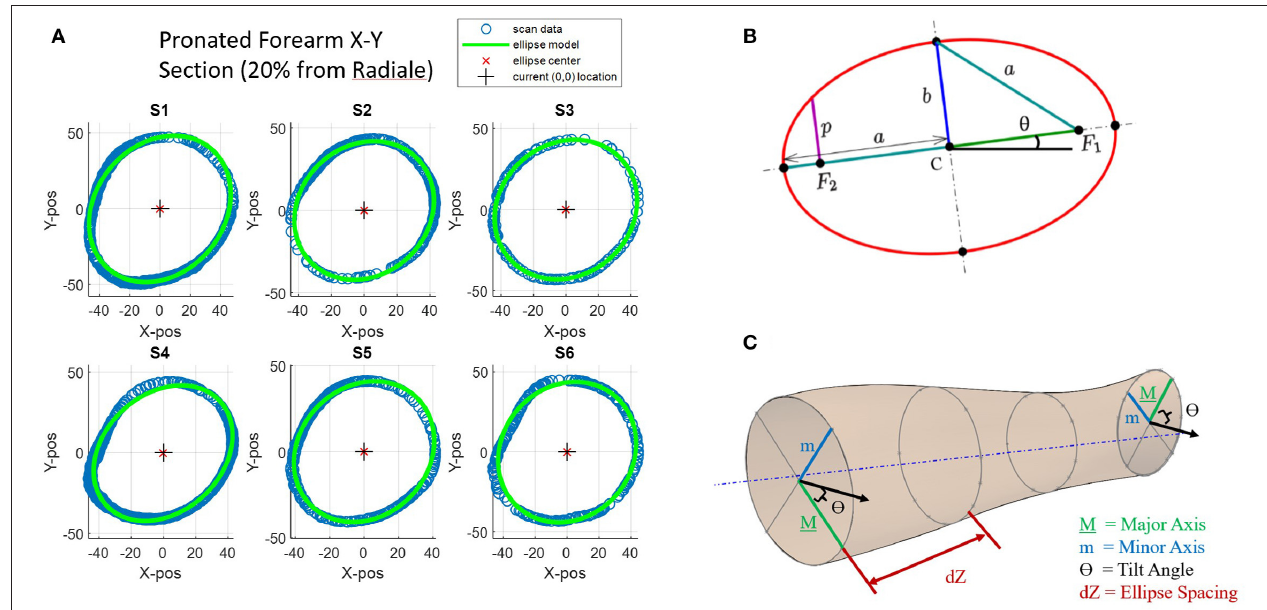
FIGURE 4 | Key ellipse-fitting parameters and approach: (A) Transverse slices of forearm data for subjects 1–6 (S1–S6) and 2D ellipse-fit models. (B) General parameters of a 2D ellipse include major diameter a , minor diameter b , angle of tilt θ , center point C , and foci F 1 and F 2 . (C) Ellipse-fit parameters used to generate 2D elliptical slices in increments dZ along the longitudinal axis generate a 3D forearm